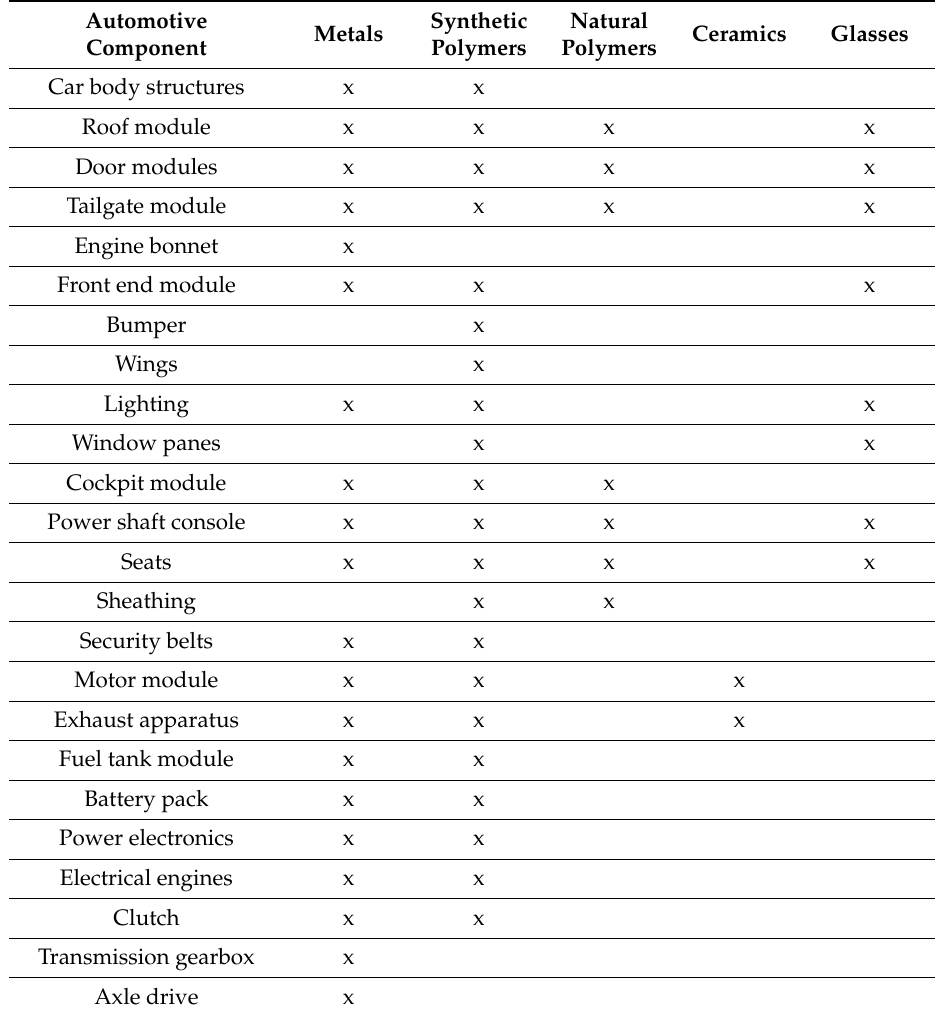
Table A2. Materials in automotive modules